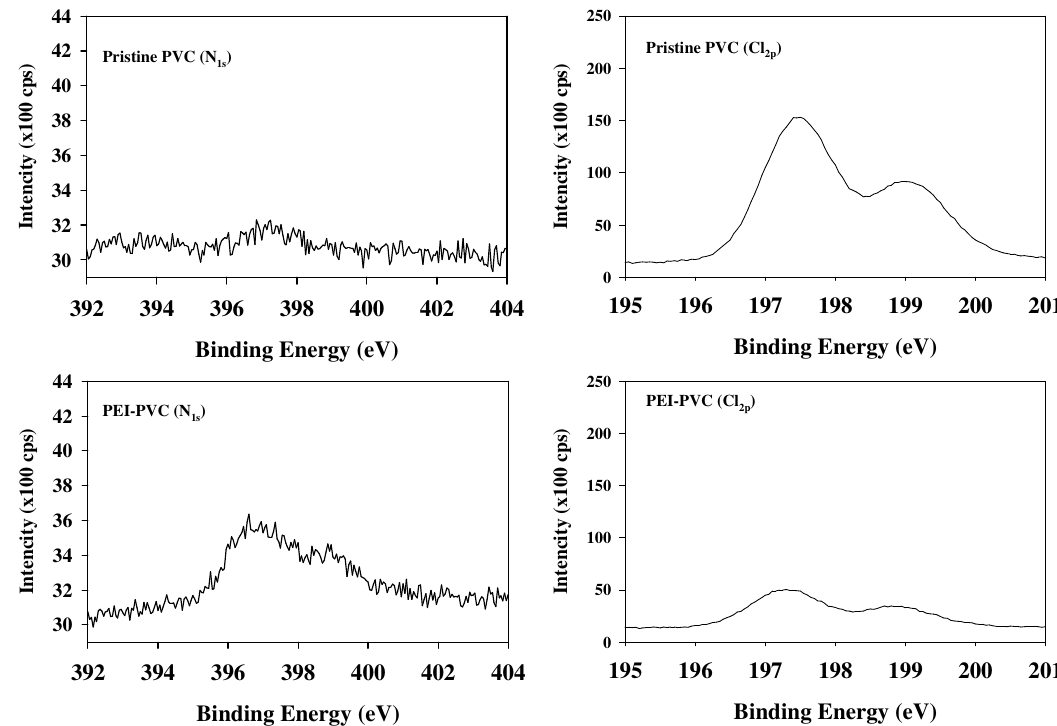
Figure 2. XPS N1s and Cl2p signals of PVC-based sorbent materials.